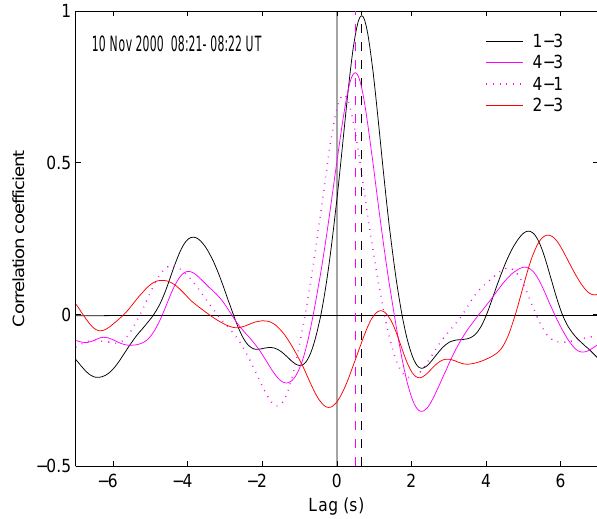
Fig. 9. A comparison of the magnetic field magnitudes measured at different spacecraft pairs in the same format as Figs. 5 and 6.